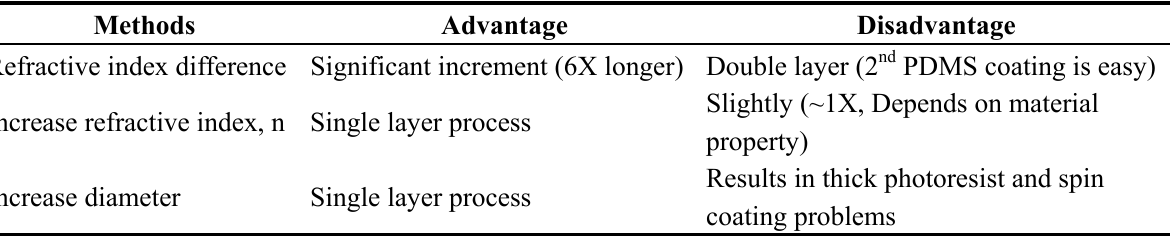
Table 2. Methods for increasing the focal length of